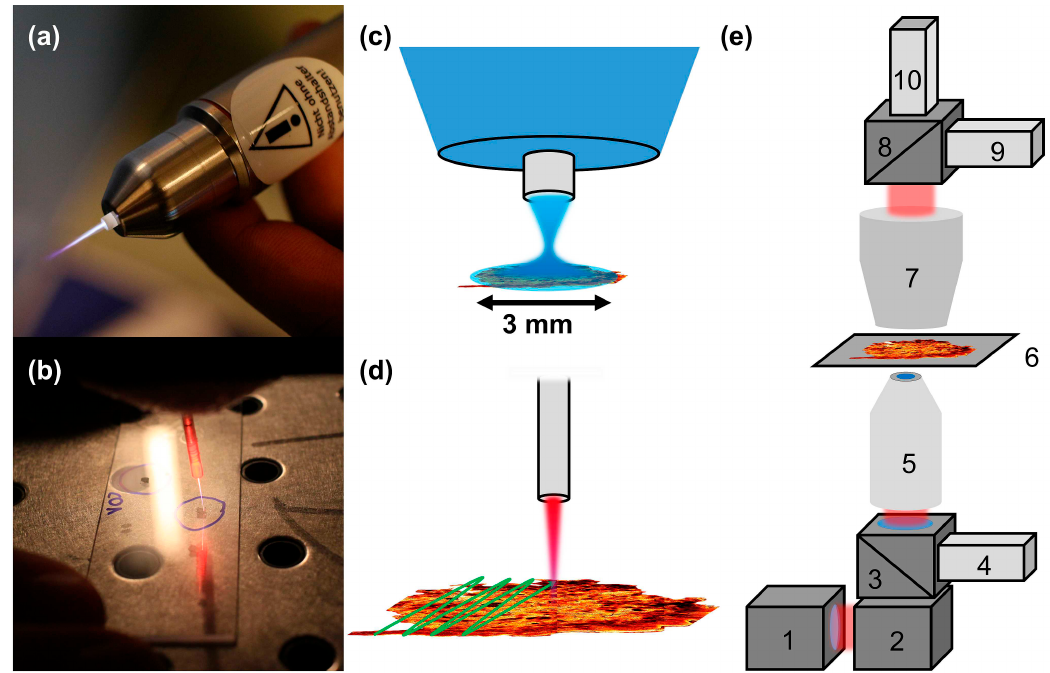
Figure 1. Photographs of kINPen-device ® ( a ) and endoscopic plasma device ( b ) during operation; ( c ) Sketch of treatment of a thin tissue section using the kINPen-device ® as shown in ( a ). The plasma covers the whole area of the tissue sections under investigation, approximately 3 × 3 mm² in size. ( d ) The plasma jet of the endoscopic plasma device shown in panel ( b ) is moved across the area of the specimen for treatment of the full section. ( e ) Scheme of the setup used for multimodal nonlinear microscopy combining coherent anti-Stokes Raman scattering (CARS), second harmonic generation (SHG) and two-photon fluorescence lifetime imaging (2P-FLIM). The picosecond (ps) pulse trains of the Ti: sapphire laser/optical parametric oscillator (OPO) system (1) is coupled into the laser scanning microscope (2). The laser light is focused onto the sample by a microscope objective (5) for image acquisition by scanning the specimen (6). Two-photon excited autofluorescence (TPEF) signals are collected by the objective (5) and reflected to the 2P-FLIM detector (4) by a 600 nm short pass dichroic mirror (3). The TP-FLIM signal is filtered from residual laser light by a 650 nm short pass filter and a 458/64 nm bandpass filter (both Semrock, Rochester, MN, USA). The CARS and SHG signals from the sample are collected in a forward direction by a condenser (7), split by a 514 nm long pass dichroic mirror and detected by photomultiplier tube (PMT) modules (9 SHG, 10 CARS) after spectral filtering as described in Section 2.3.